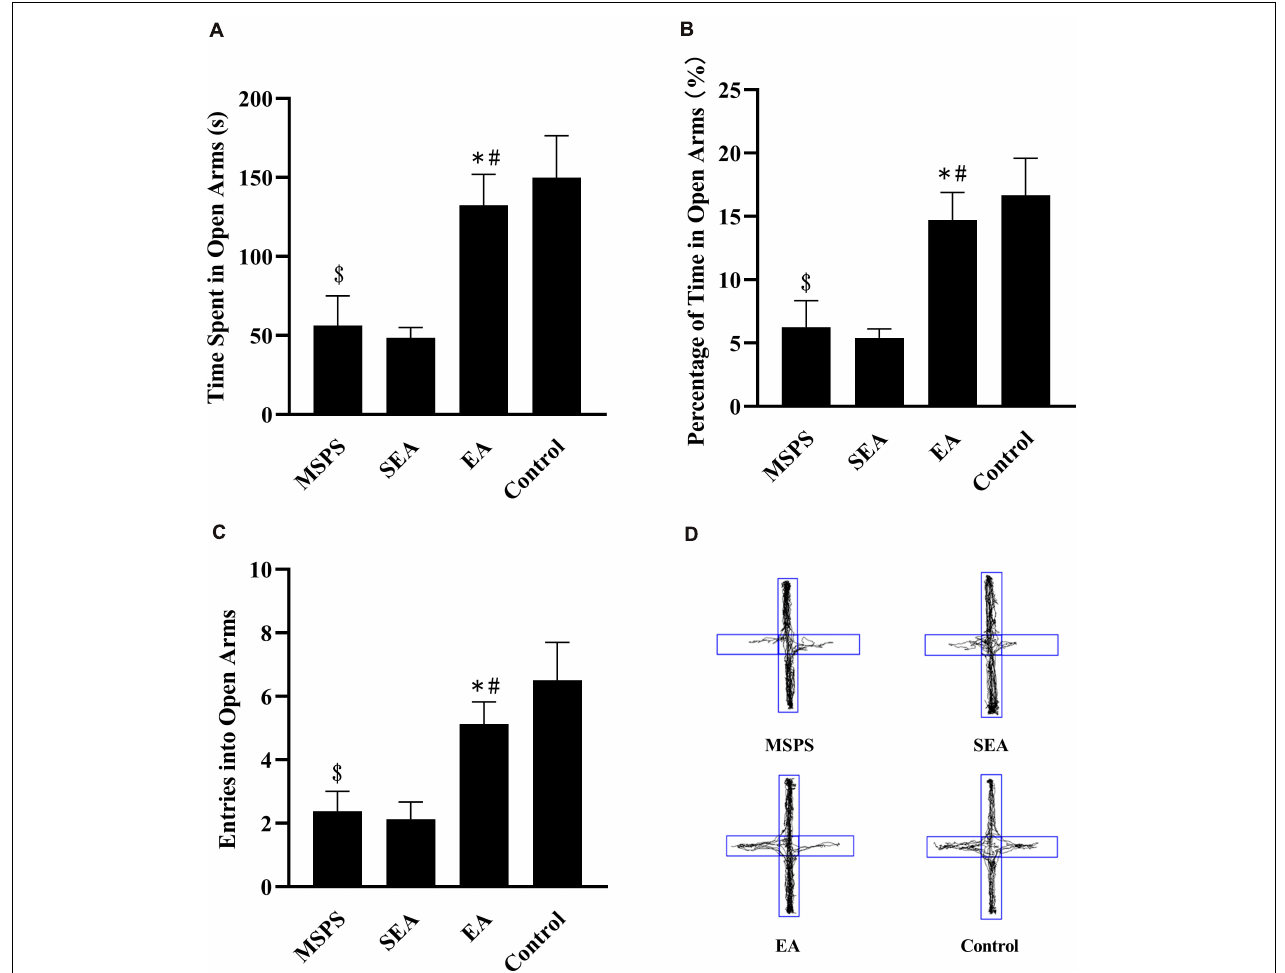
FIGURE 2 | Impacts of EA at ST36 on anxiety-like behaviors in MSPS rats as measured in an EPM. (A) Time spent in the open arms in seconds. (B) Percentage of time spent in open arms. (C) Open arm entries. (D) Representative tracking plots. Data are means ± S.E.M. ( $ P < 0.05, PTSD vs. control groups; * P < 0.05, EA vs. SEA groups; # P < 0.05, EA vs. PTSD